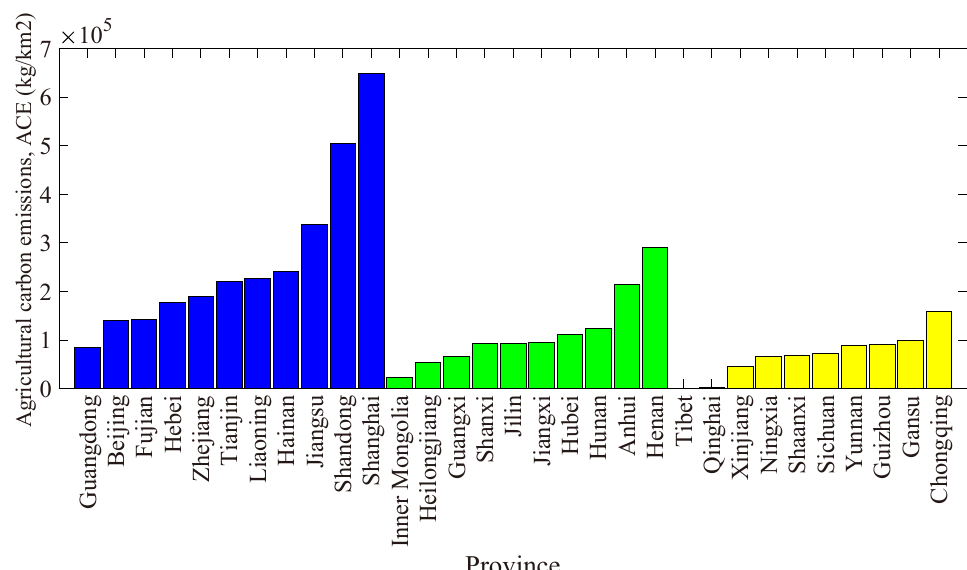
Figure 3. ACE per unit area of the 31 provinces by regions, 2019. Figure 4 shows the regional aggregate ACE (kg) and their growth rate (%). In general, the middle region has the highest ACE and the western region has the lowest ACE. Remem- ber that the land sizes of the eastern, middle and western regions are different (generally 2:6:11). Combined with Figure 3, we can find that the eastern region has the highest ACE per km 2 but does not have the highest aggregate amount ACE. The main possible reason is the relatively small land size. Similarly, perhaps due to the lowest ACE per km 2 , the western region has the largest land size but has the lowest aggregate ACE. On the other hand, since the national ACE is the sum of the ACE of these three regions, the significant up and down trend in national ACE is not mainly determined by the eastern region.